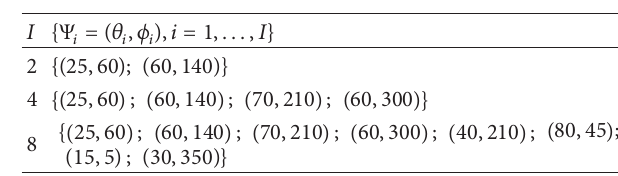
Table 1: Fully populated array—( 𝑁 = 25 ; 𝑑 𝑥 = 𝑑 𝑦 = 0.5𝜆 ; 𝐼 ∈ [2 : 8] ; SNR = 10 dB; 𝐶 = 50 )—actual DoAs of the impinging